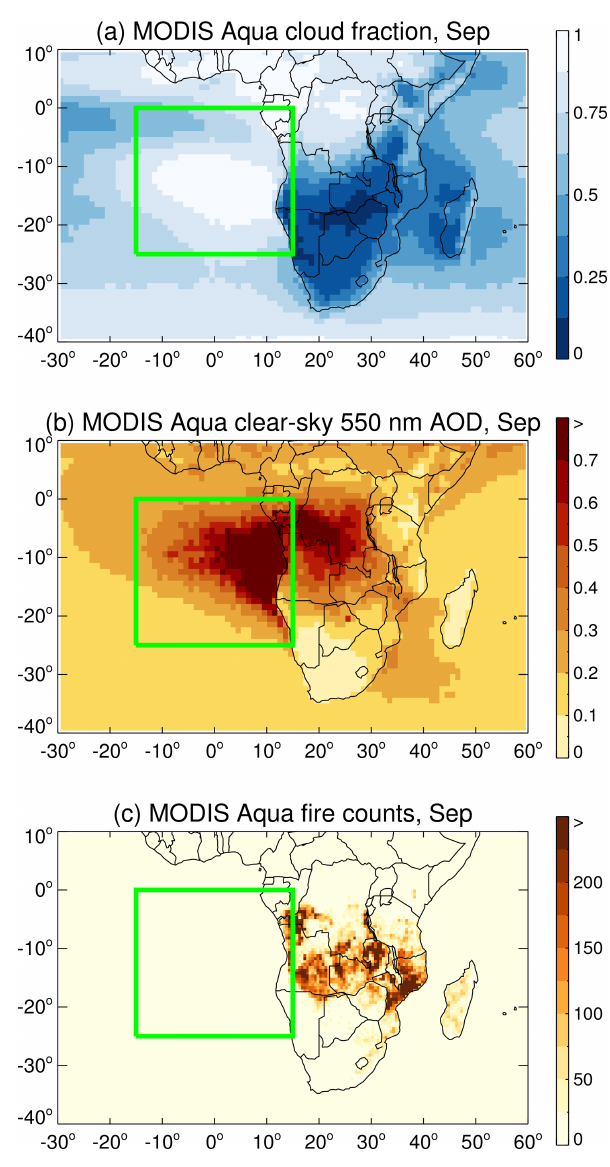
Figure 2. Long-term (2002–2015) mean MODIS Aqua (a) day- time cloud fraction, (b) clear-sky total column AOD at 550nm, and (c) total fire counts for the month of September for central and southern Africa and surrounding regions. Cloud and aerosol data are at 1 ◦ horizontal resolution, while fire counts are at 0.5 ◦ horizontal resolution. The green box (25 ◦ S–0 ◦ N, 15 ◦ W–15 ◦ E) denotes the approximate region of focus for the ORACLES campaign